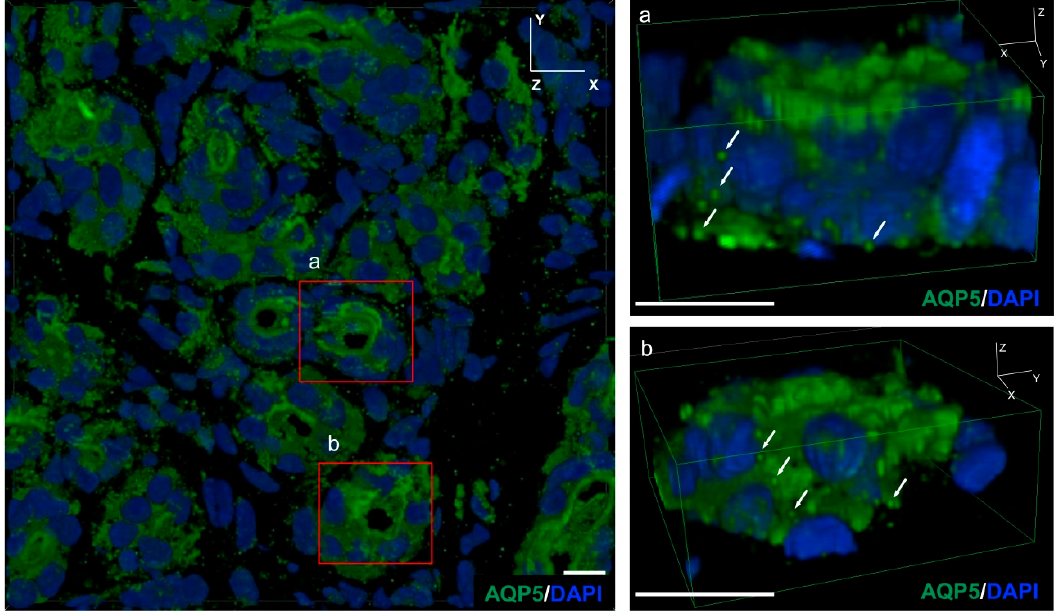
Figure 2. A 3D analysis of the AQP5 vesicles localization in mouse eccrine cells. Mouse skins were immunostained with AQP5 (green) and counter stained with DAPI (nuclei). ( a , b ): The white arrows highlight AQP5 ‐ immunoreactive vesicles in the cytoplasm of mouse skin. Scale bar = 10 μ m.